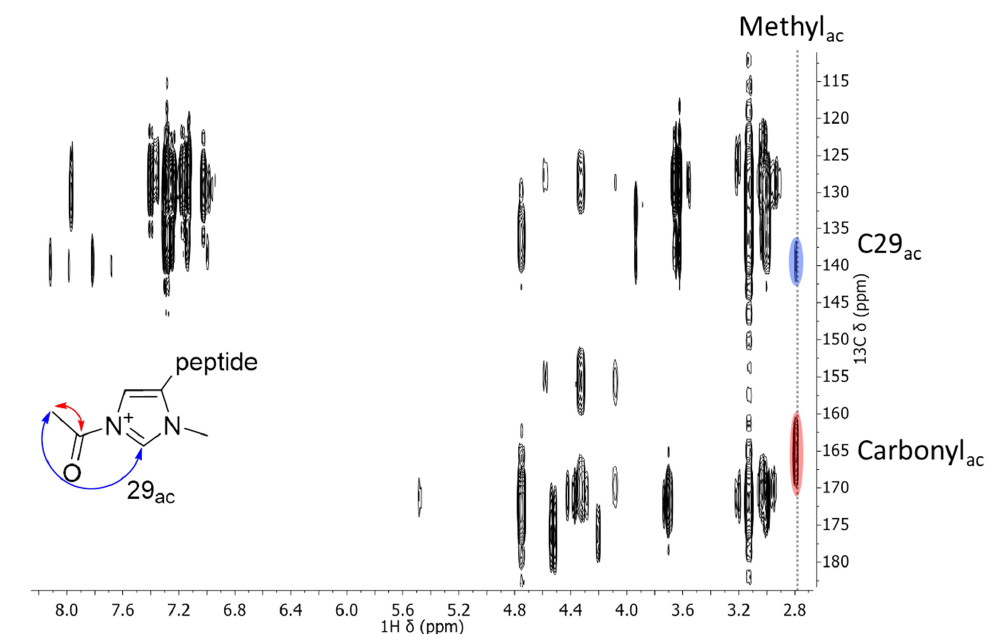
Figure S11. Selective 1D-1H-NOE spectrum of tetrapeptide 1 with acetic anhydride 3 in DCM-d2 at -20 °C (700 MHz 1H frequency). Excitation at the H29ac resonance at 10.6 ppm.)).